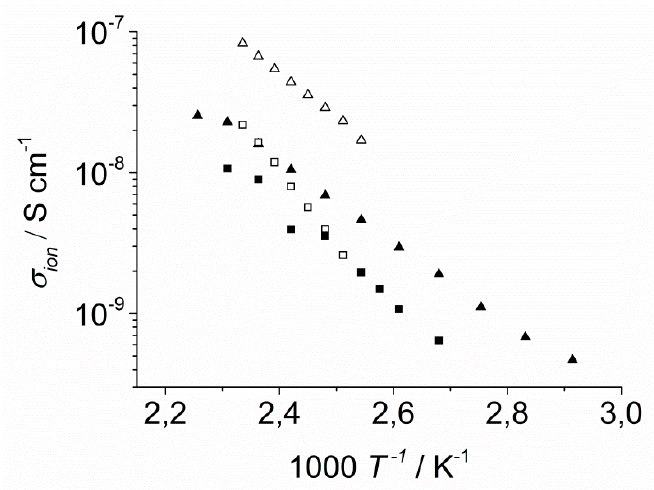
Figure 14. Arrhenius diagram of the ionic conductivity of LiI-1a ( ■ ), LiI-1b ( ▲ ) KI-2a (□), and KI-2c (∆). Both pairs of compounds with neat and filled symbols, respectively, bear the same ion pairs but they differ in side chain length.